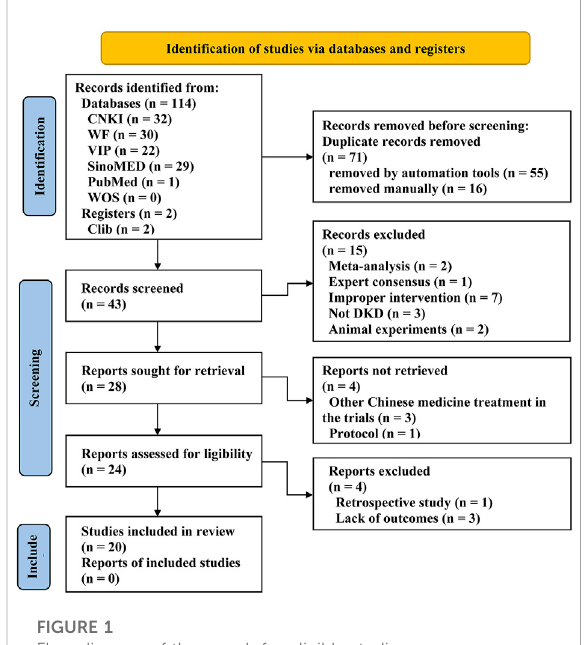
FIGURE 1 Flow diagram of the search for eligible